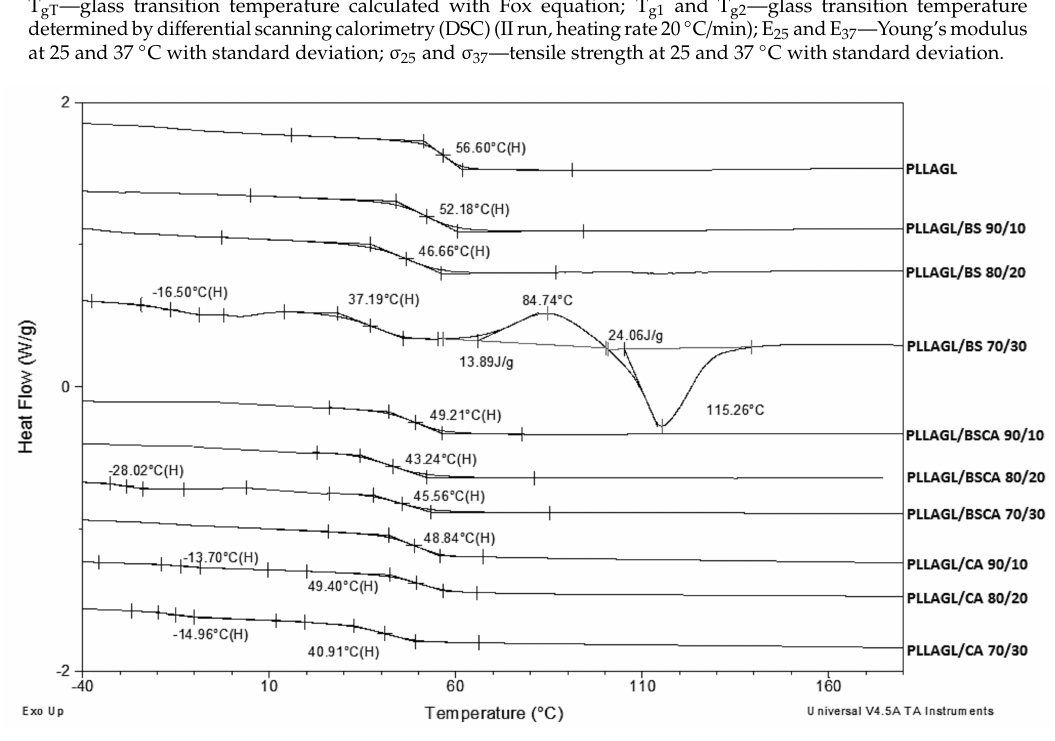
Figure 1. DSC thermograms (II run, heating rate of 20 ◦ C /